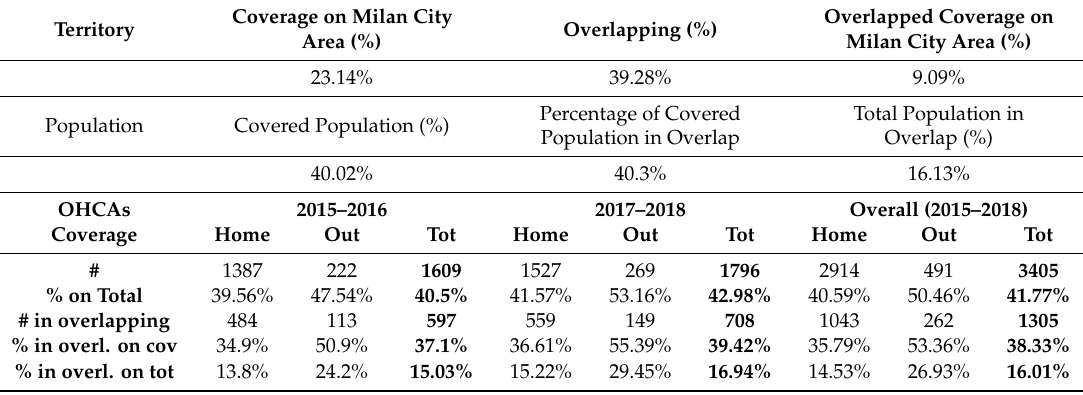
Table 1. Results of performance analysis of the initial distribution of Automated External Defibrillators (AEDs). Out-of-Hospital Cardiac Arrest (OHCA) coverage values are reported separately for residential events (‘Home’), non-residential ones (‘Out’) and aggregated (‘Tot’, enlightened in bold).